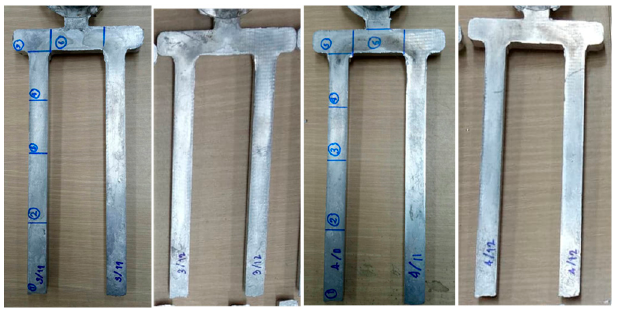
Figure 10. Rheo - die - cast samples at different speeds and pressures . From left to right: 3 m/s-11 MPa, Figure 10. Rheo-die-cast samples at di ff erent speeds and pressures. From left to right: 3 m / s-11 MPa, 3 3 m/s-12 MPa, 4 m/s-11 MPa, and 4 m/s-12 MPa. m / s-12 MPa, 4 m / s-11 MPa, and 4 m / s-12